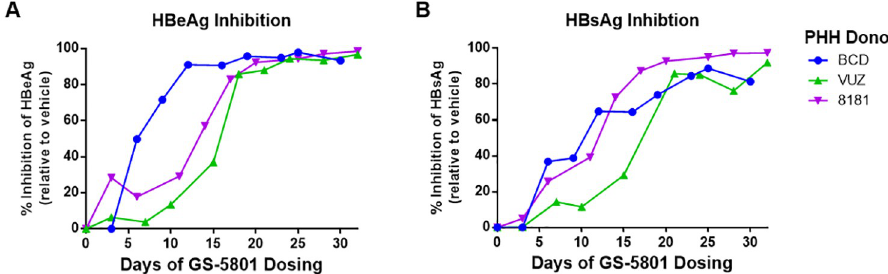
Fig 3. Antiviral activity of GS-5801 exhibits delayed kinetics. PHH from three donors (BCD, VUZ, and 8181) were infected with HBV for three days prior to initiation of GS-5801 treatment. PHH were dosed with vehicle or 10 μ M GS- 5801 every three to four days for a total of 30–32 days. At the timepoints shown, levels of secreted (A) HBeAg and (B) HBsAg were measured by immunoassay. Data are plotted as the percentage inhibition of HBeAg or HBsAg in GS-5801 treated PHH relative to vehicle treated